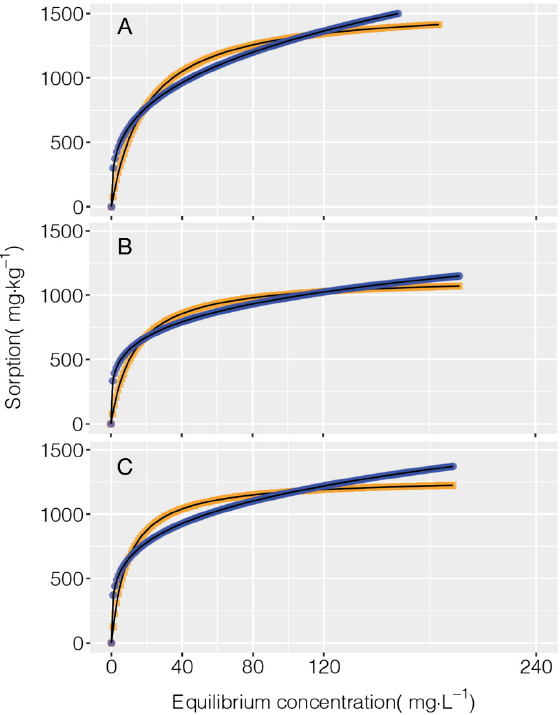
Figure 2. P adsorption isotherms fitted to the Langmuir (yellow) and Freundlich models (blue) in mining soil without the addition of organic amendments ( A ), with compost ( B ), and with biochar ( C